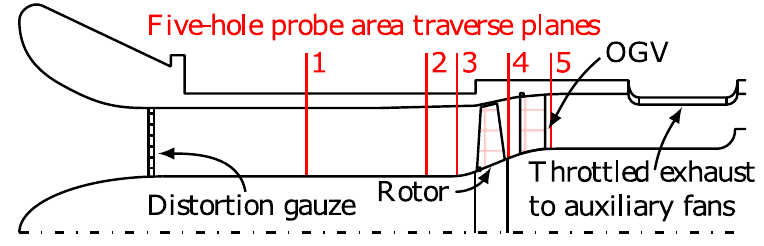
Figure 17. Meridional view of the BLI fan rig.